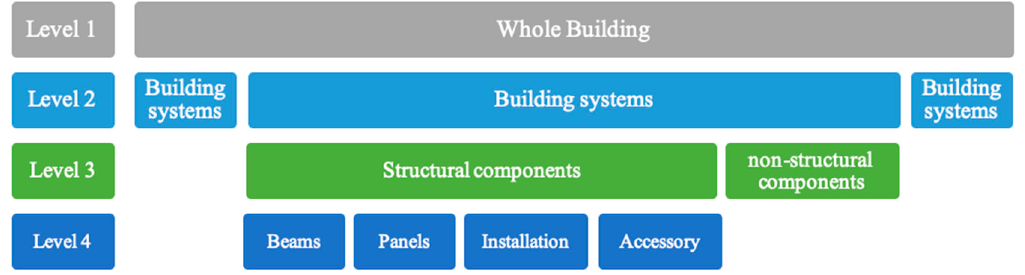
Figure 1. Level of prefabrication (adopted from